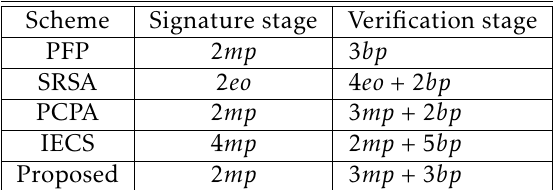
Table 1. Performance Comparison of Different Schemes